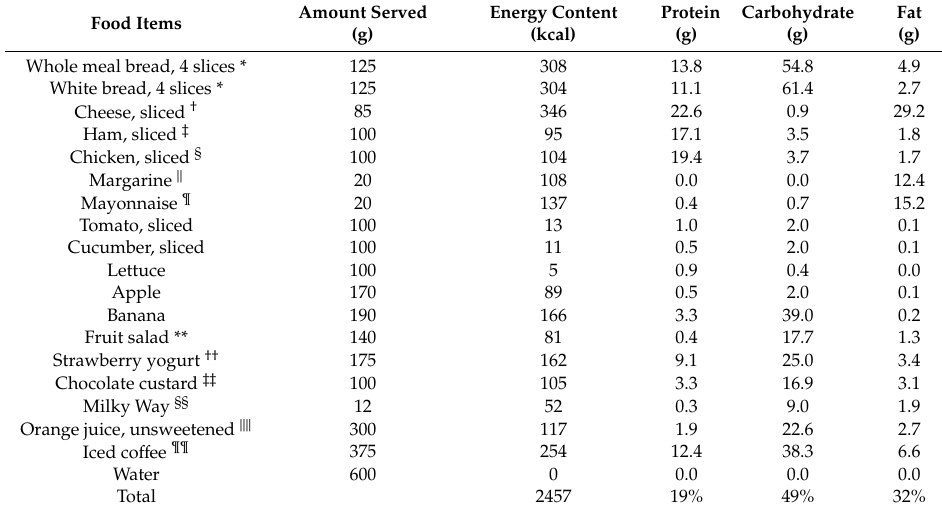
Table 1. Composition of the cold bu ff et-style breakfast and lunch